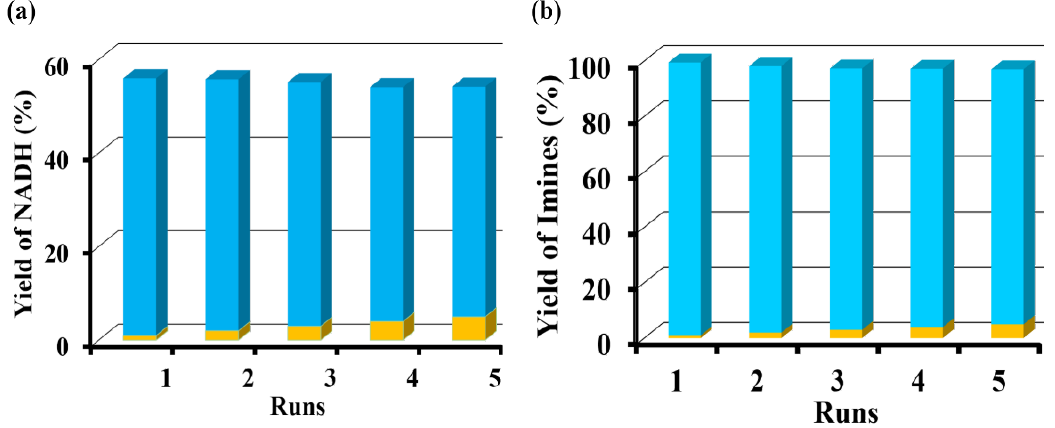
Figure 8. Photostability test of NGQDs@EC photocatalyst for ( a ) 1,4-NADH regeneration and, ( b ) Formation of Imine.